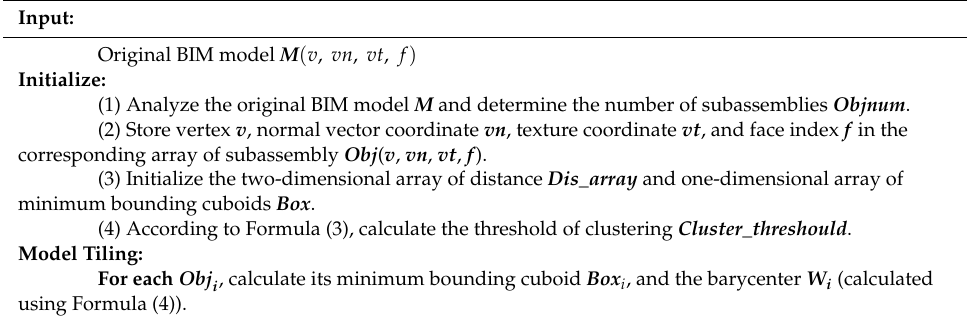
Algorithm 1 Tiling method for BIM